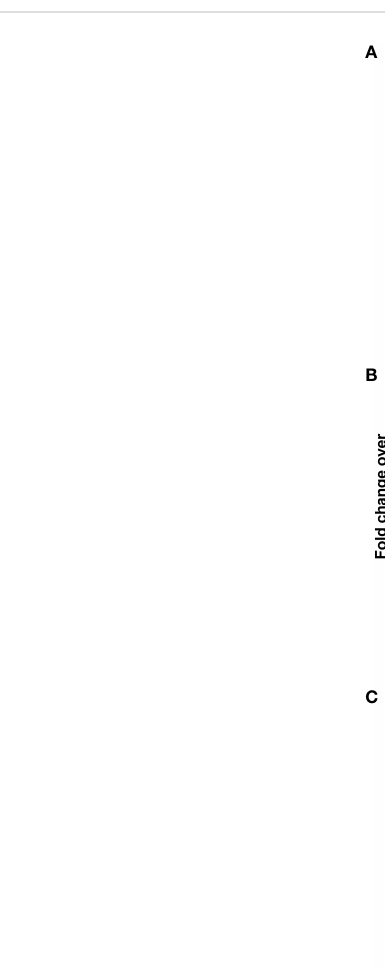
FIGURE 1 Total, binding and neutralizing antibody titers at time of challenge in serum. Titers of infused antibodies were measured in hamsters at the time of challenge (study day 0). (A) Serum total levels of the infused human antibodies as assessed by human IgG or IgM ELISA assays. (B) Serum SARS-CoV- 2 speci fi c IgG/IgM responses as assessed by multiplex antibody binding assay to the Hexapro stabilized spike protein (C) Serum SARS-CoV-2 S- speci fi c pseudovirus neutralization. Virus neutralization reciprocal 50% inhibitory dilution (ID 50 ) is shown. X-axis values indicate mg/kg of IgM or IgG administered to animals. Dotted lines indicate the lower limit of detection for the assay. Horizontal bars indicate group